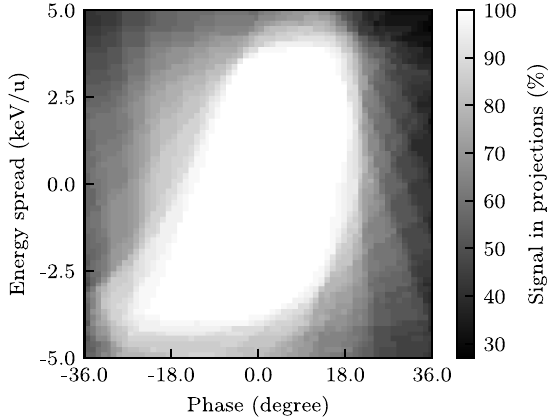
FIG. 5. By back projecting the traces onto the input plane, areas are marked in which no signal is present and vice versa.